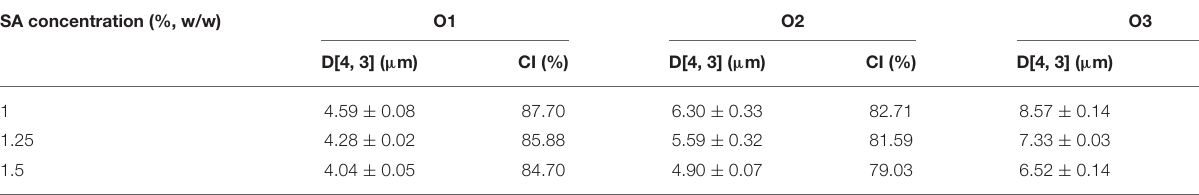
TABLE 5 | Particle size and creaming index of emulsions with different oil phase volumes. SA concentration (%, w/w)